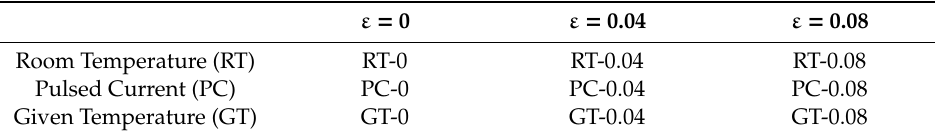
Table 1. Samples are denoted according to deformation conditions and